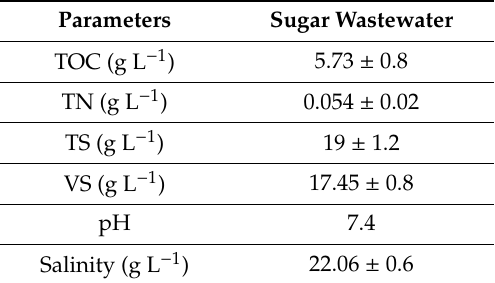
Table 1. Chemical composition of sugar wastewater.